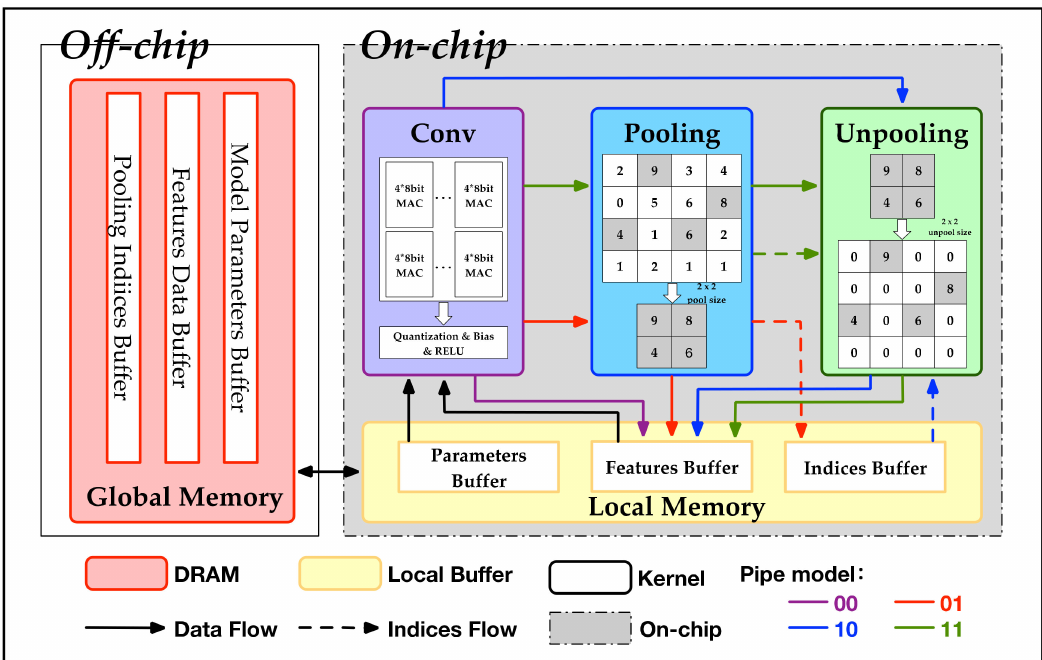
Figure 4. The architecture of the SegNet